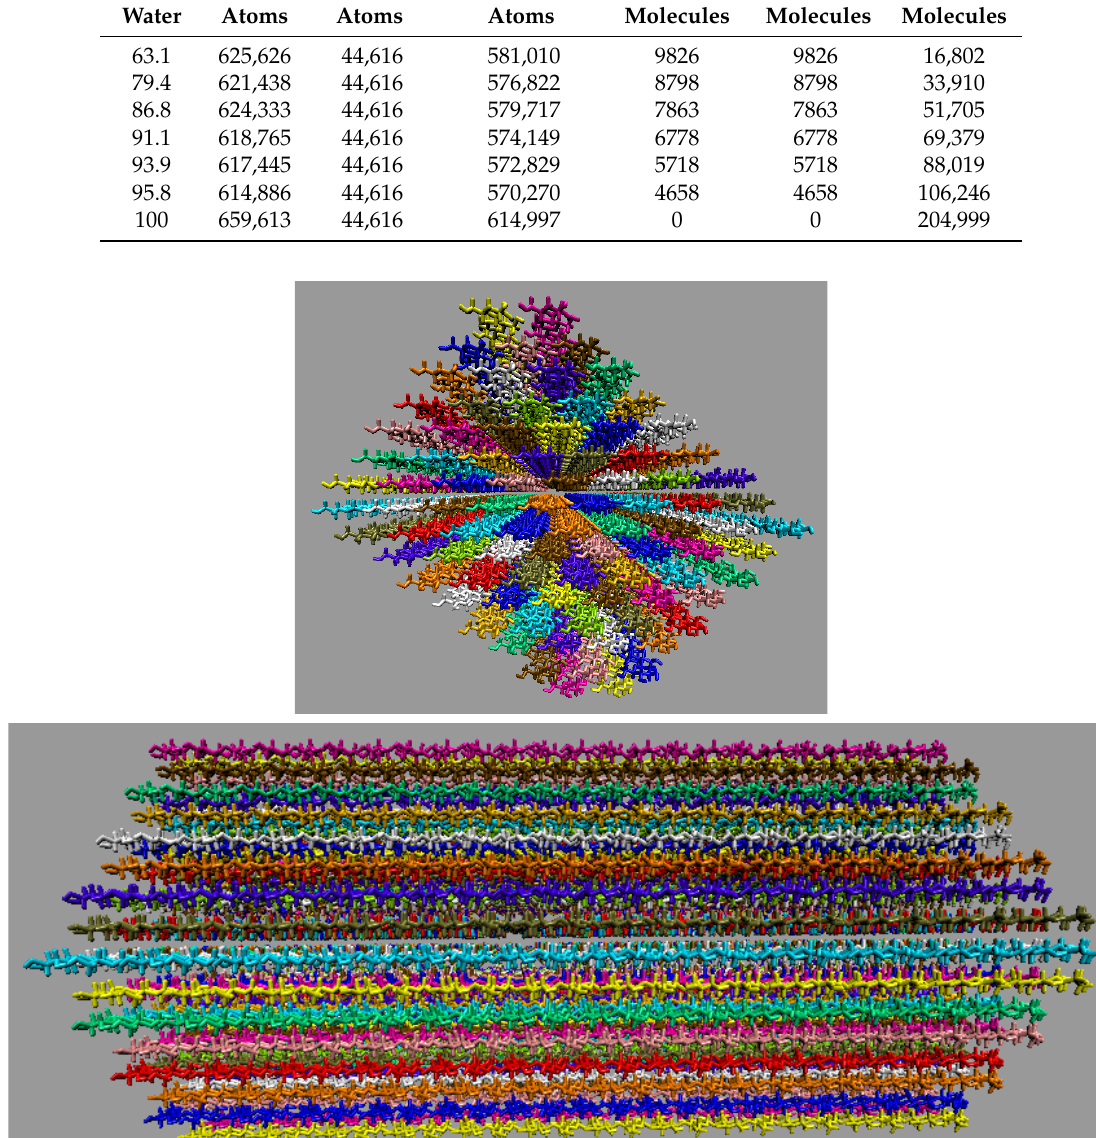
Figure 5. The initial configuration of the large I β cellulose bundle constructed via Cellulose-Builder [25]. The cellulose bundle has 88 individual strands with 24 glycan units per strand. The mirror image cellulose strands are identified using the same color